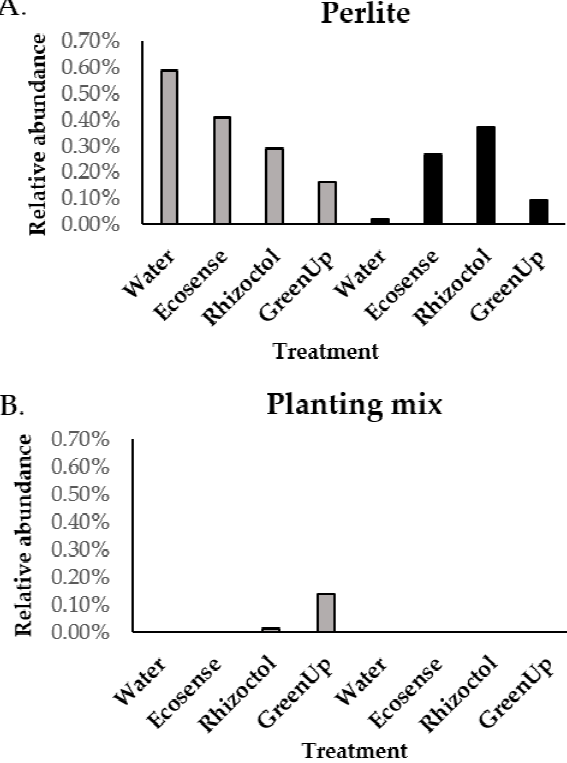
Figure 2. Presence of Enterobacteriaceae bacteria in the root environments of Ornithogalum dubium and Zantedeschia aethiopica in two growth media. Columns represent the relative frequency of DNA sequences identified as belonging to the family Enterobactriaceae in samples of soil surrounding the roots of O. dubium (gray) and Z. aethiopica (black) in ( A ) perlite and ( B ) a planting mix. There were three replicates of each treatment.